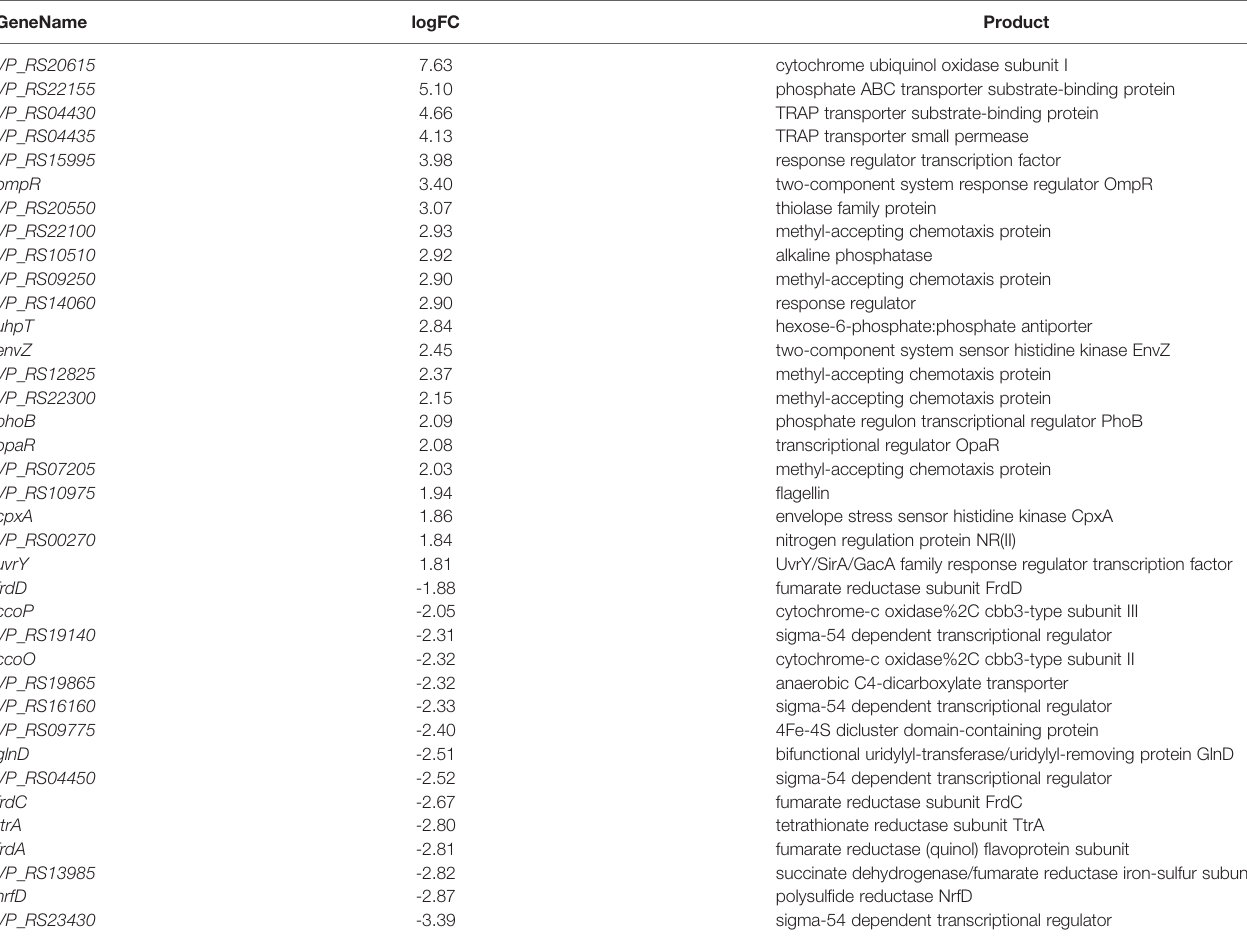
TABLE 1 | Analysis of differential gene expression of Two-component system.